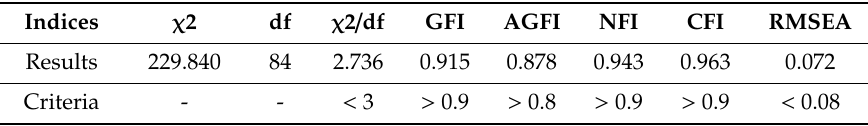
Table 5. Fit Indices.